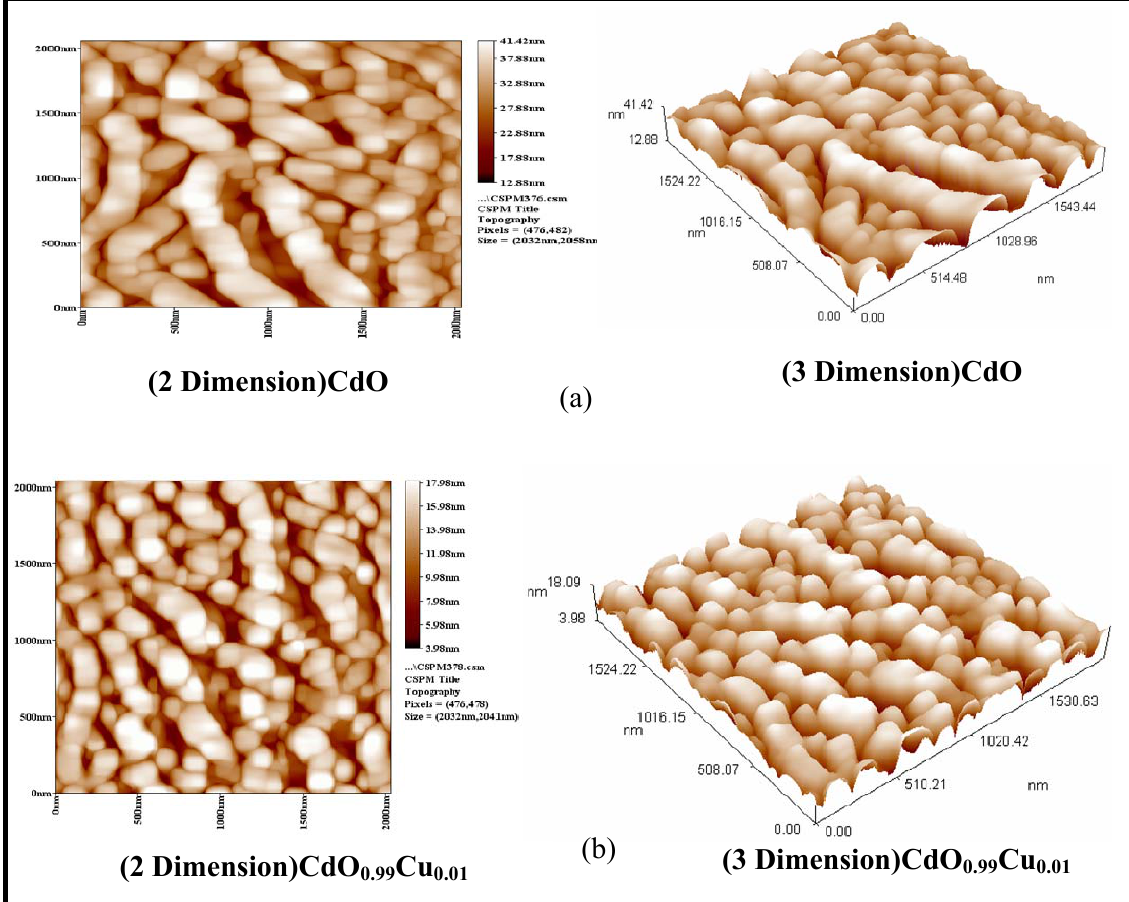
Fig.2a, b: AFM images (2D and 3D) of CdO and CdO